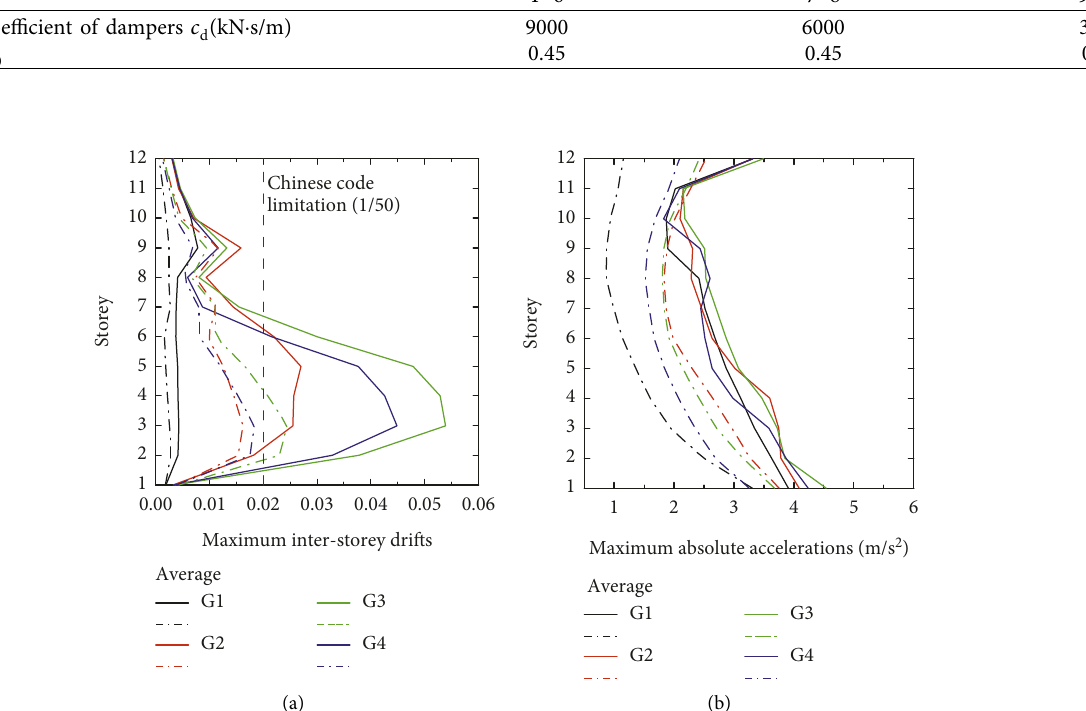
Figure 13: Comparisons of maximum seismic response of the steel frame with and without VDs: (a) maximum interstorey drifts and (b) maximum absolute accelerations. (—represent the structure without VDs; – · –represent the structure with VDs).